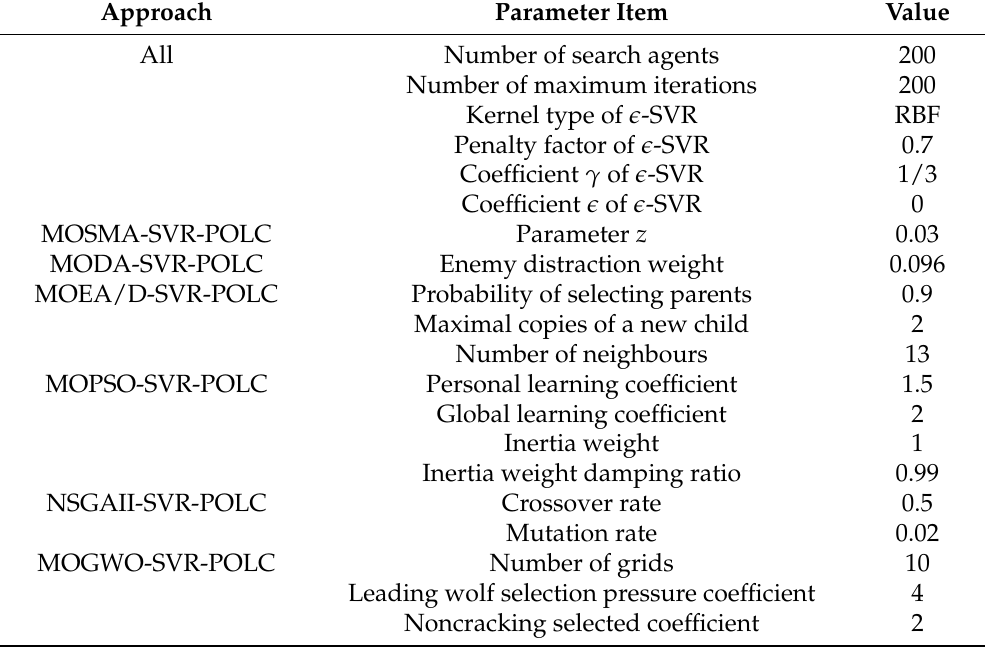
Table 3. Parameter setting of MOSMA-SVR-POLC and other